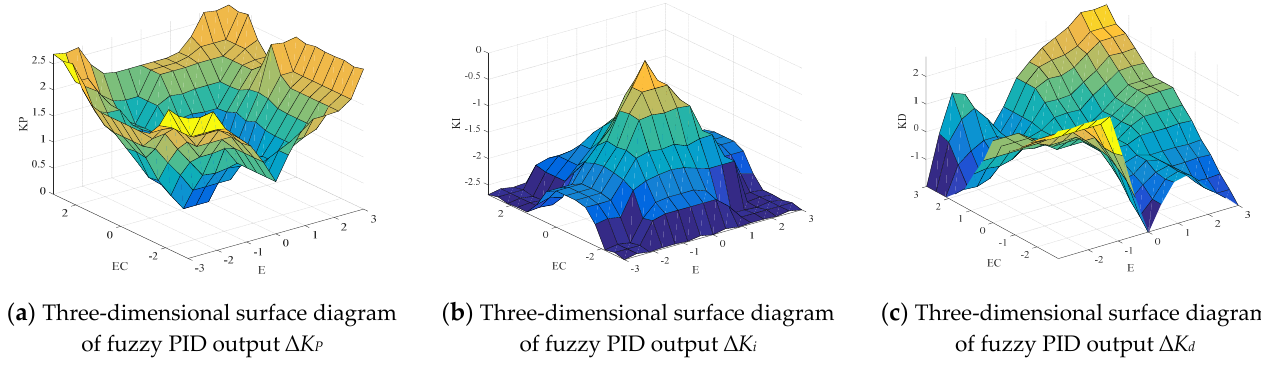
Figure 11. Three-dimensional curved surface diagram of fuzzy PID output ∆ K P , ∆ K i and ∆ K d .